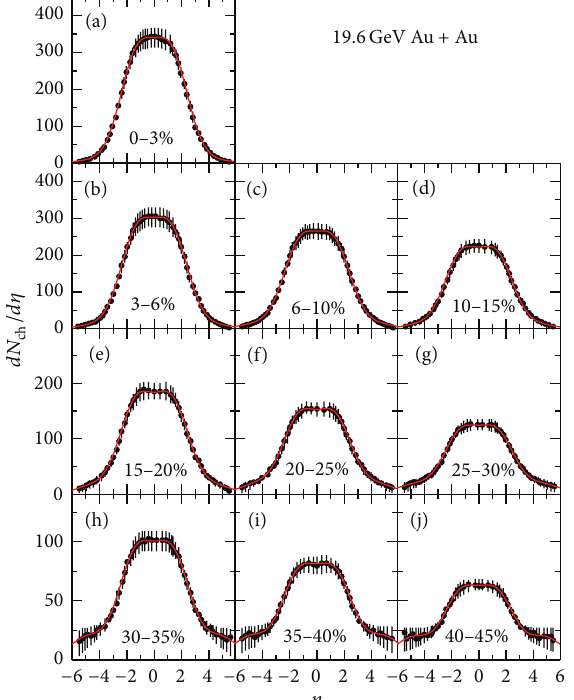
/𝑑𝜂 versus 𝜂 for different centrality bins in Au-Au Figure 1: 𝑑𝑁 ch collisions at √𝑠 𝑁𝑁 = 19.6 GeV. The circles and curves represent the experimental data of the PHOBOS collaboration [27] and our calculated results, respectively.